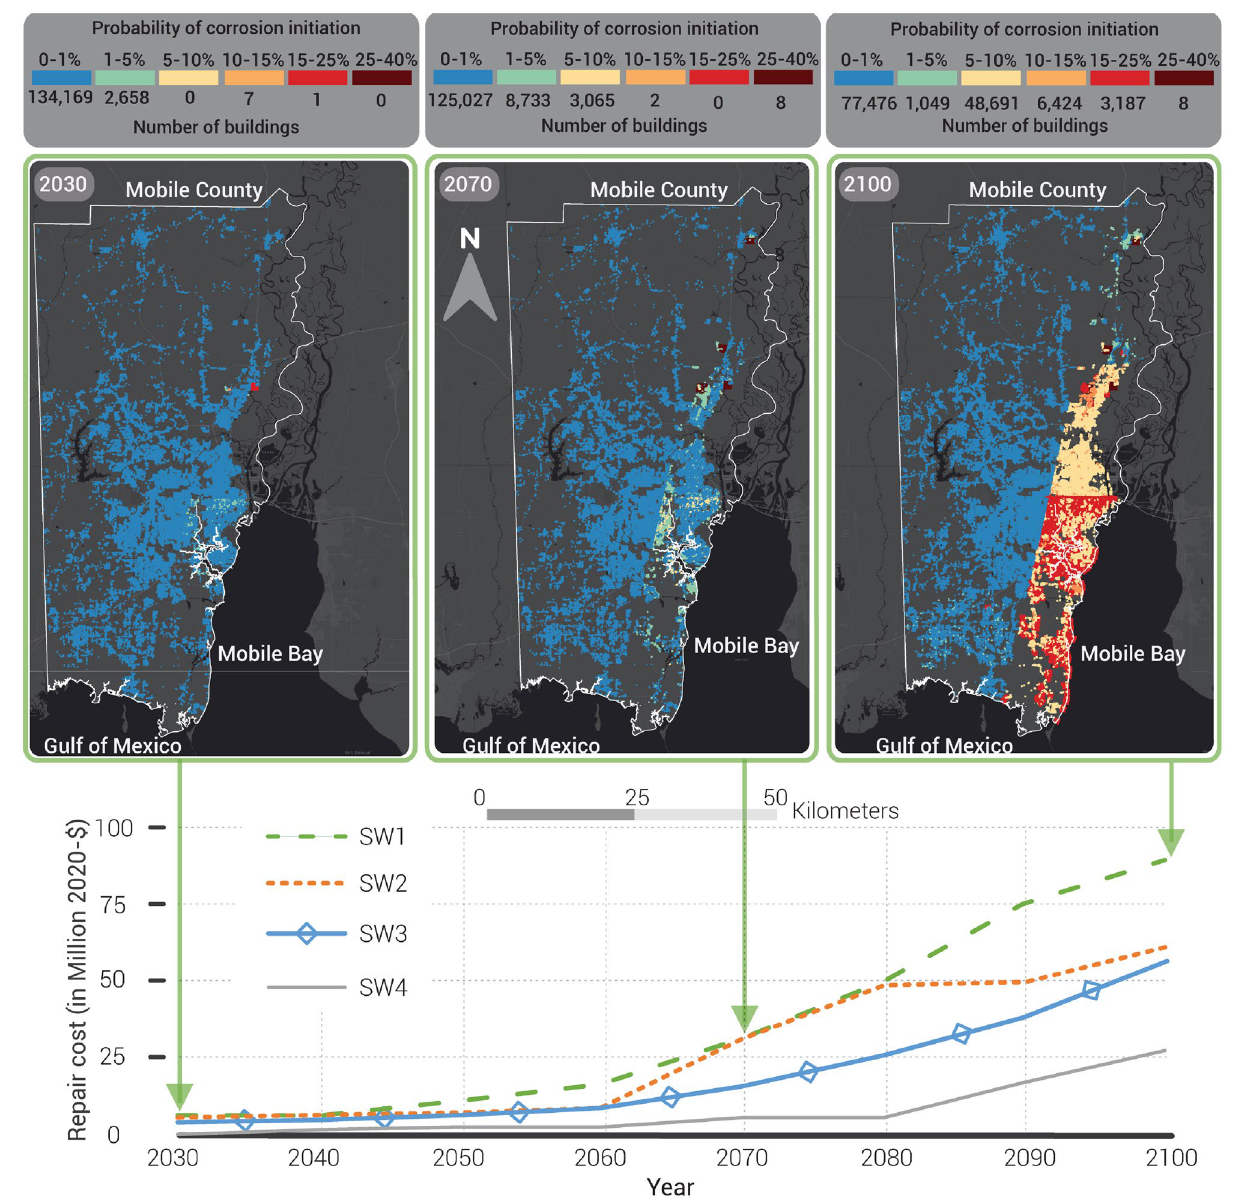
Figure 4. The repair cost in the absence of any mitigation under each scenario with the probability of corrosion initiation on the foundation of residential buildings under the SW1 scenario. The software used to develop the maps in this figure is QGIS 3.16 (https:// qgis.